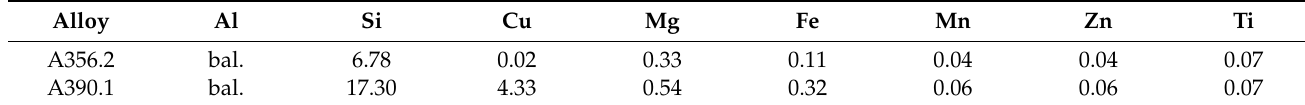
Table 1. Composition of the A356.2 and A390.1 alloys